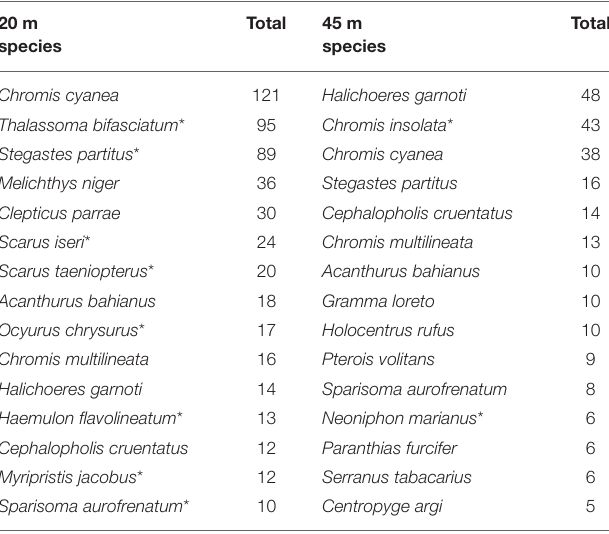
TABLE 2 | The fifteen most common fish species for each